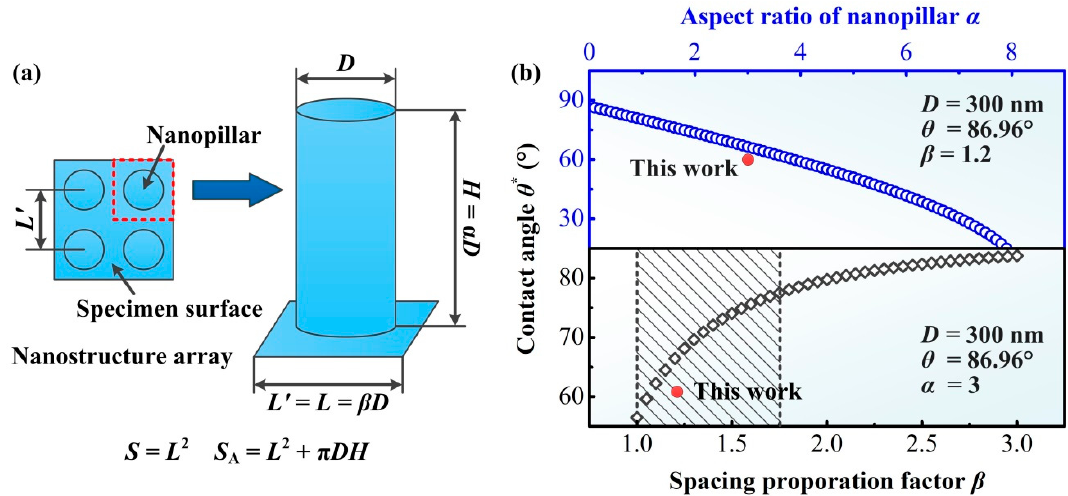
Figure 9. ( a ) Geometric parameter of BMG nanostructure array. ( b ) The apparent contact angle of the as-embossed ZrY 1.5 BMG surface based on Wenzel’s model.